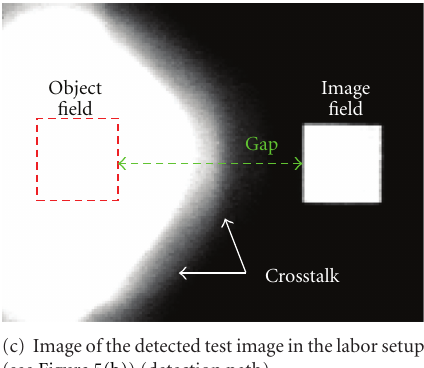
Figure 4: Image of test image and the detected photodiode image applying the 3D sensor system application (triangulation angle). The red square highlighted the object projection field. Due to the crosstalk e ff ect the projection and detection fields have to be